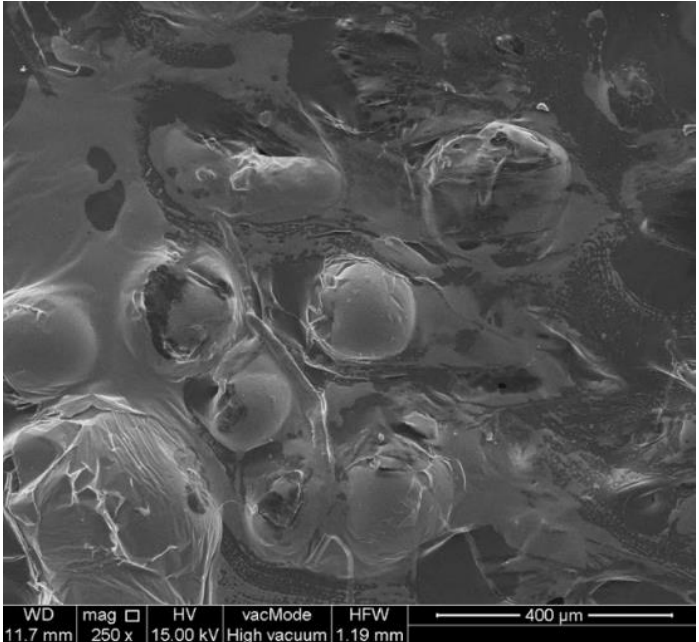
Figure 3. SEM image of silver nanoparticles produced in SNPAC method by 100 µL of Tilia cordata extract.